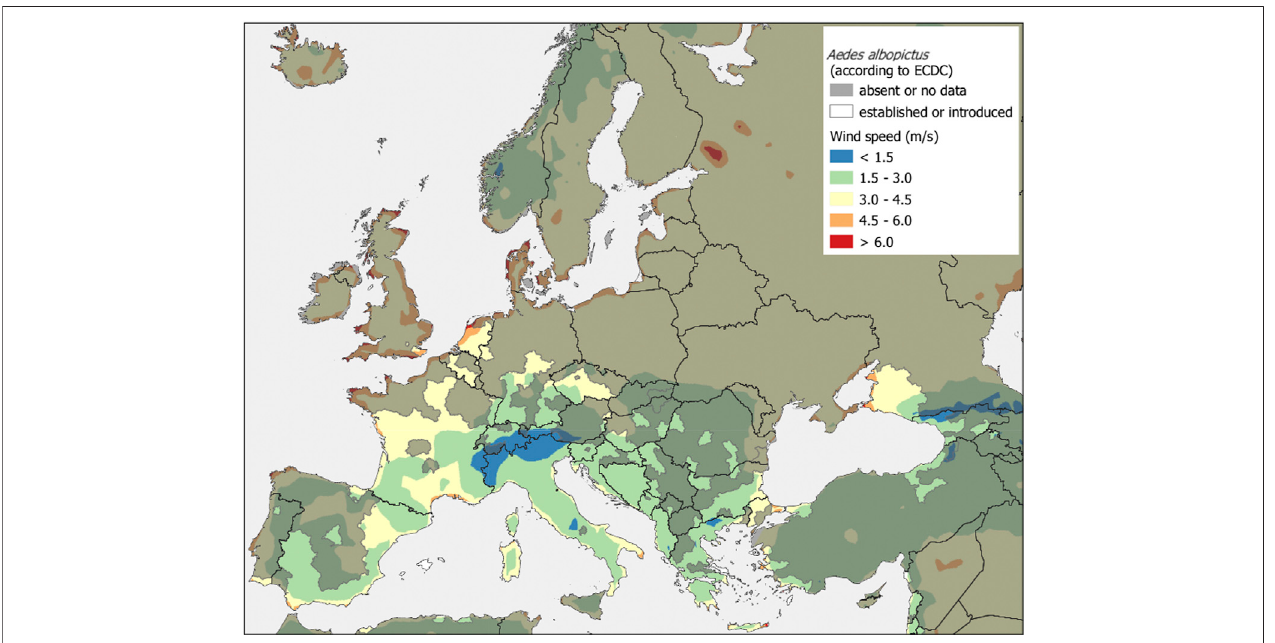
FIGURE 1 | Wind speed (ms − 1 ) in areas with established or introduced Aedes albopictus populations. Most areas where the mosquito has become established show wind speeds ranging from 1.5 ms − 1 to 4.5 ms − 1 . The wind speed values represent air movement at 10-m height and were acquired from the ERA5 monthly average reanalysis data set for the period of 1999 – 2018 (Copernicus Climate Change Service, 2021). The establishment status across Europe was adopted from the ECDC/EFSA 5 known distribution of the species (March 2021).